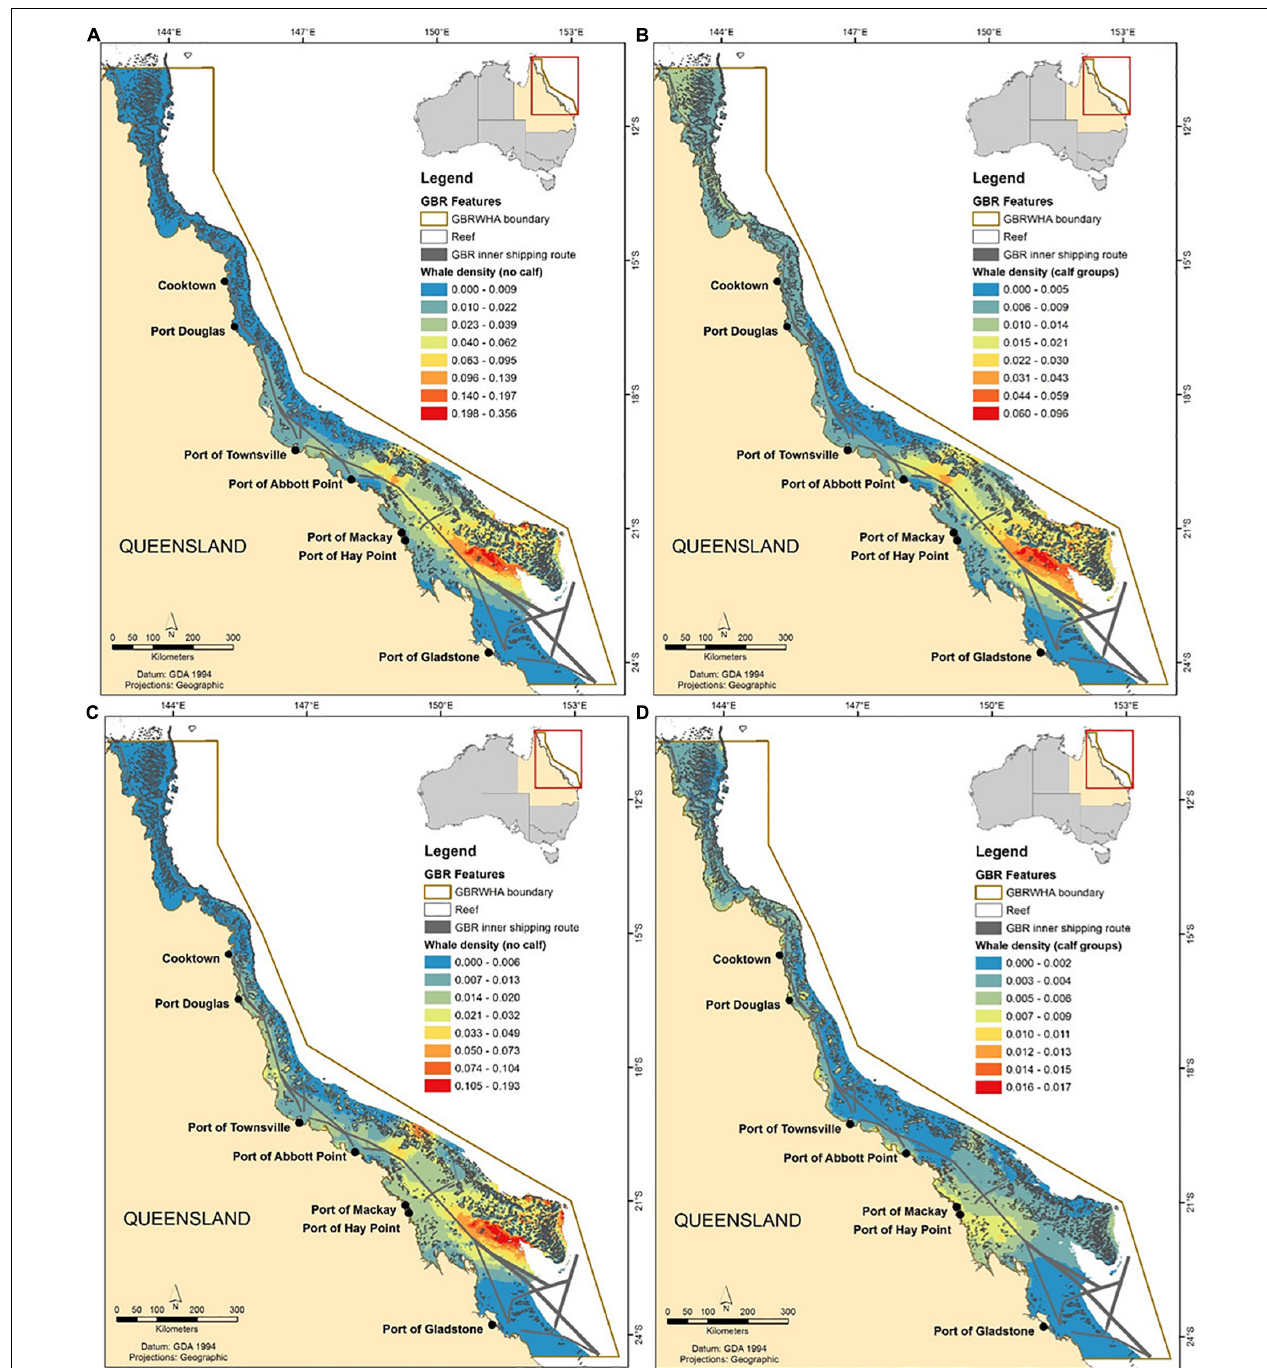
FIGURE 3 | Modeled distribution and densities of humpback whale (A) non-calf groups and (B) calf groups in August 2012 and (C) non-calf groups and (D) calf groups in September 2014 in the Great Barrier Reef Marine Park with the overlayed inner shipping route.